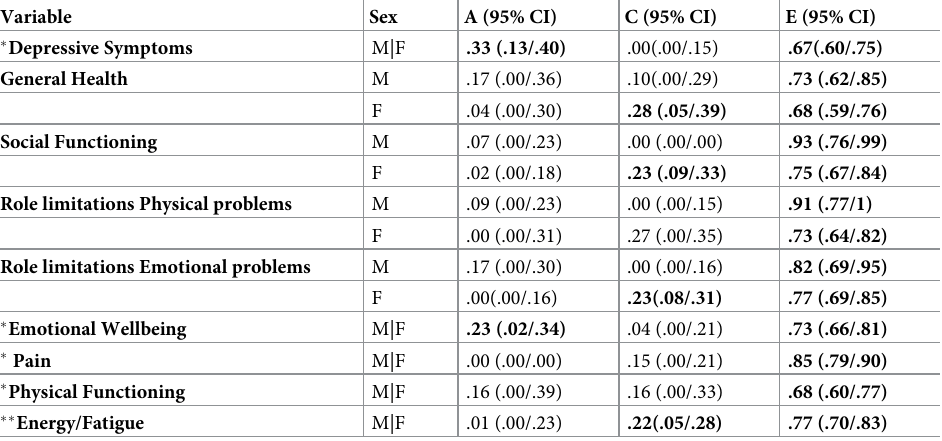
Table 4. Variance decomposition (univariate ACE estimates) for depressive symptoms and SF-36 scales.